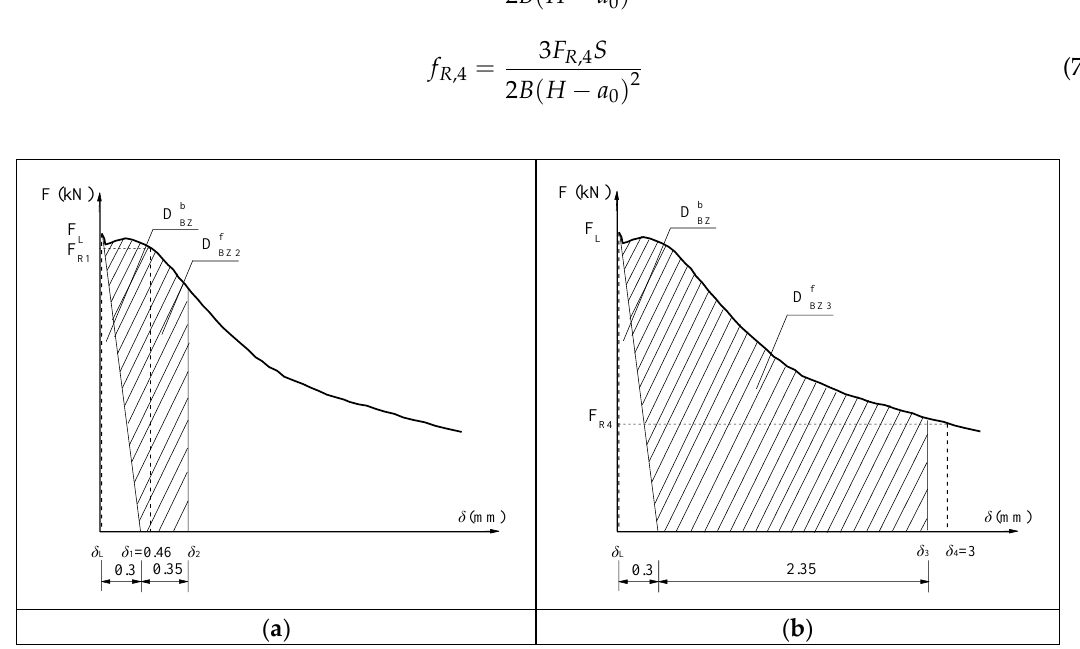
Figure 8. Evaluation of residual and equivalent flexural strengths (RILEM TC 162-TDF 2002). ( a ) Evaluation of f eq,2 and determination of F R,1 ; ( b ) Evaluation of f eq,3 and determination of F R,4 . All of the above parameters of steel fiber-reinforced SGM and SGC are reported in Table